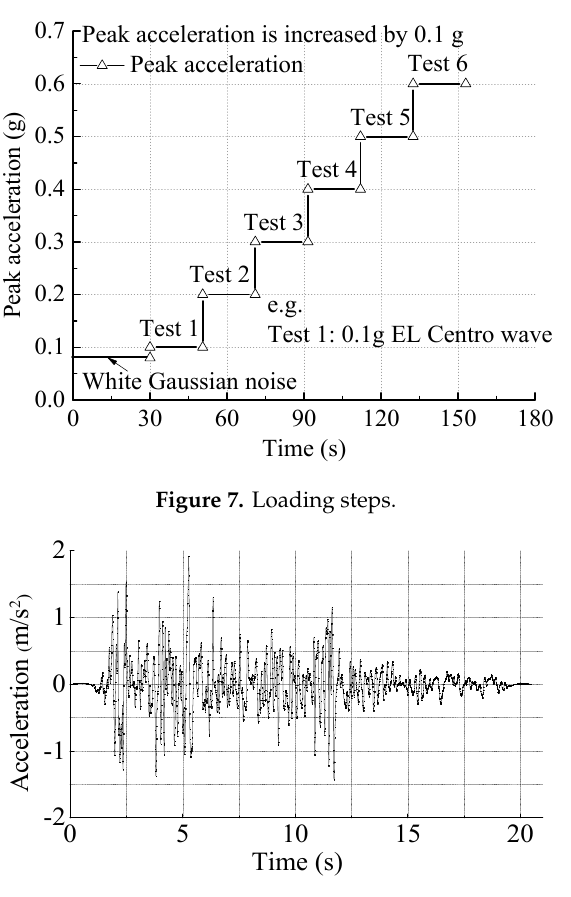
Figure 8. Time history curve of El Centro wave.